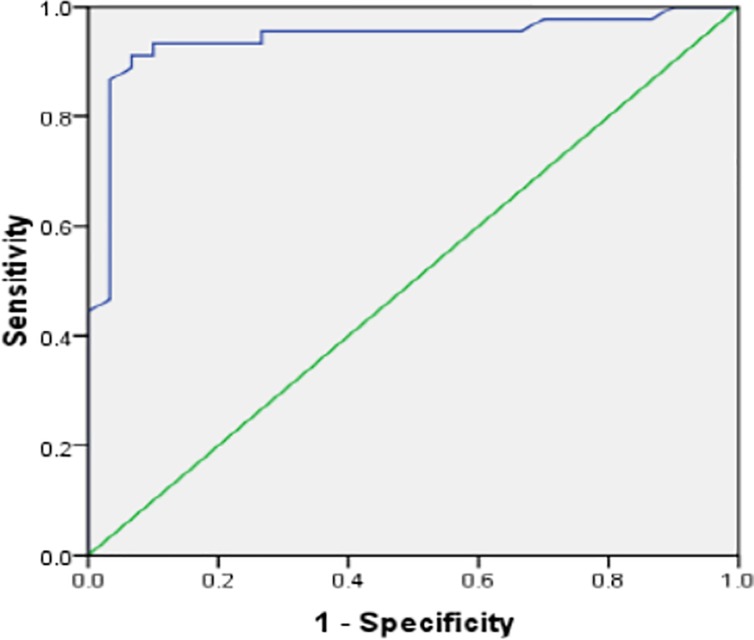
ROC Curve for optimal ARSE in detecting an ejection fraction < 55% by Simpson.